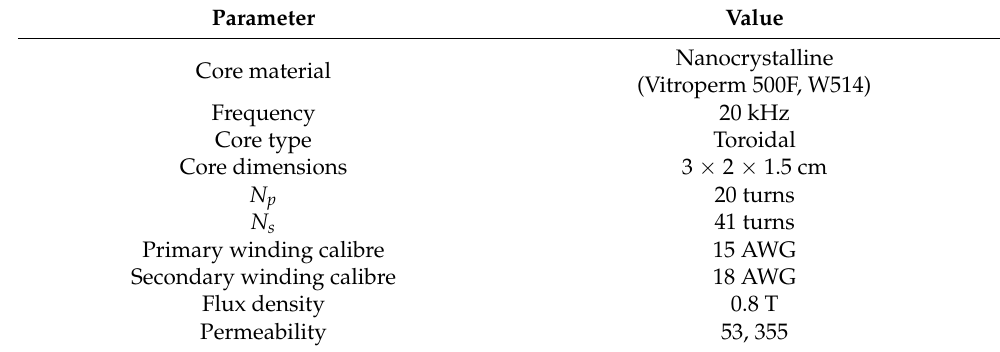
Table 3. MFT ’s parameters.